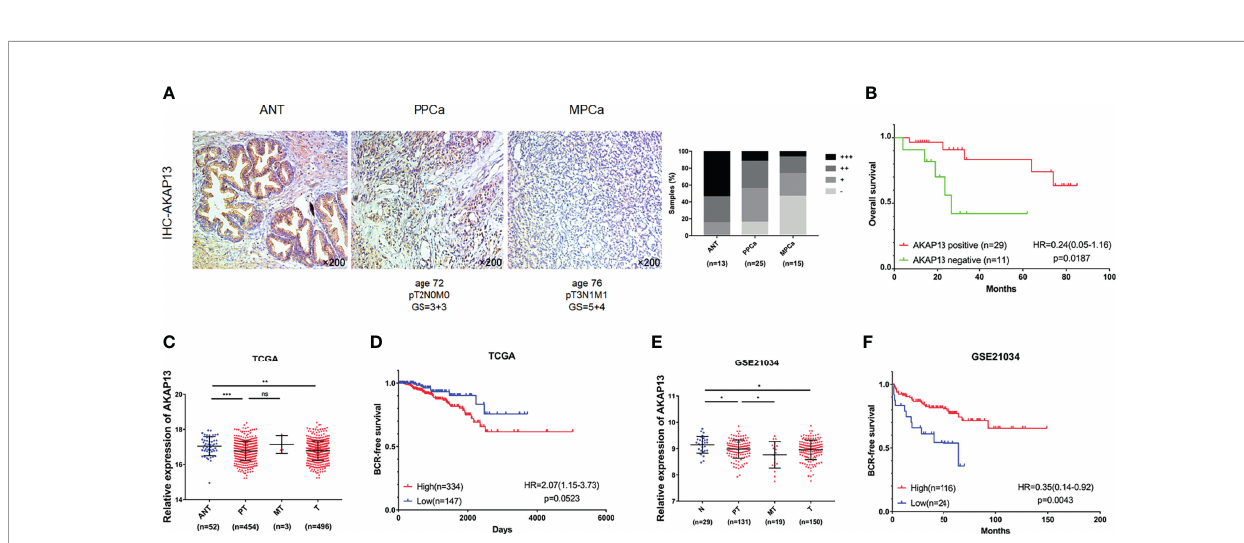
FIGURE 7 | AKAP13 expression is negatively correlated with PCa malignant degree and correlate with clinical outcomes of PCa patients. (A) AKAP13 IHC staining was performed in clinical adjacent normal tissues (n = 13) and PCa tissue samples (n = 40). Left: representative IHC photographs of ANT and tumor tissue samples (PPCa, MPCa) were shown as indicated. Right: the composition of AKAP13 different expression degree (-: negative expression; +: weak expression; ++: moderate expression; +++: strong expression) in each group of tissue samples was counted. (B) The Kaplan-Meier survival analysis of overall survival of PCa patients with different AKAP13 expression levels. (C) AKAP13 expression decreased in PCa tumor tissues compared with adjacent normal tissues in TCGA. (D) The Kaplan-Meier survival analysis of BCR-free survival about AKAP13 expression in TCGA. (E) AKAP13 expression decreased in primary localized PCa tissues and metastatic PCa tissues compared with normal tissues in GSE21034. (F) The Kaplan-Meier survival analysis of BCR-free survival about AKAP13 expression in GSE21034. Magni fi cation, ×200. The data were presented as means ± SD. ns P > 0.05; *P < 0.05; **P < 0.01; ***P < 0.001; Student ’ s t-test. ANT, adjacent normal tissues; N, normal tissues; PPCa/PT, primary localized PCa tissues; MPCa/MT, metastatic PCa tissues; T, tumor tissues; BCR, biochemical recurrence; HR, hazard